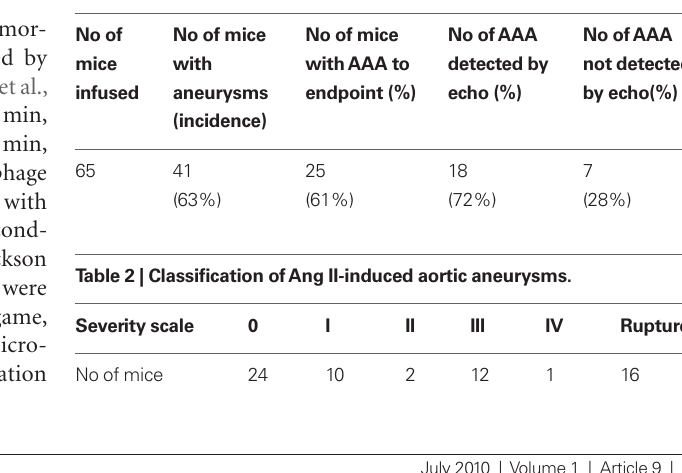
Table 1 | Summary of Ang II-induced aneurysms in apoE − / − mice.